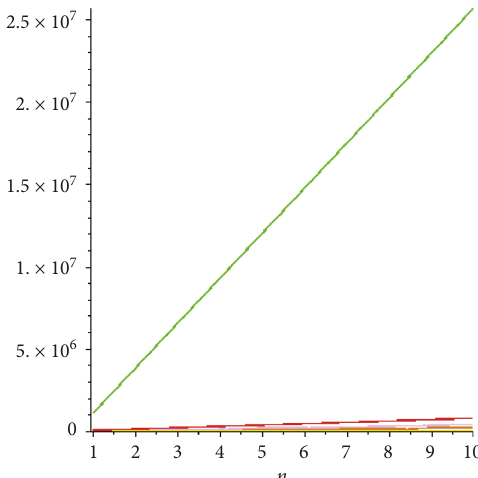
Figure 4: Graphical analysis of neighborhood degree-based topological